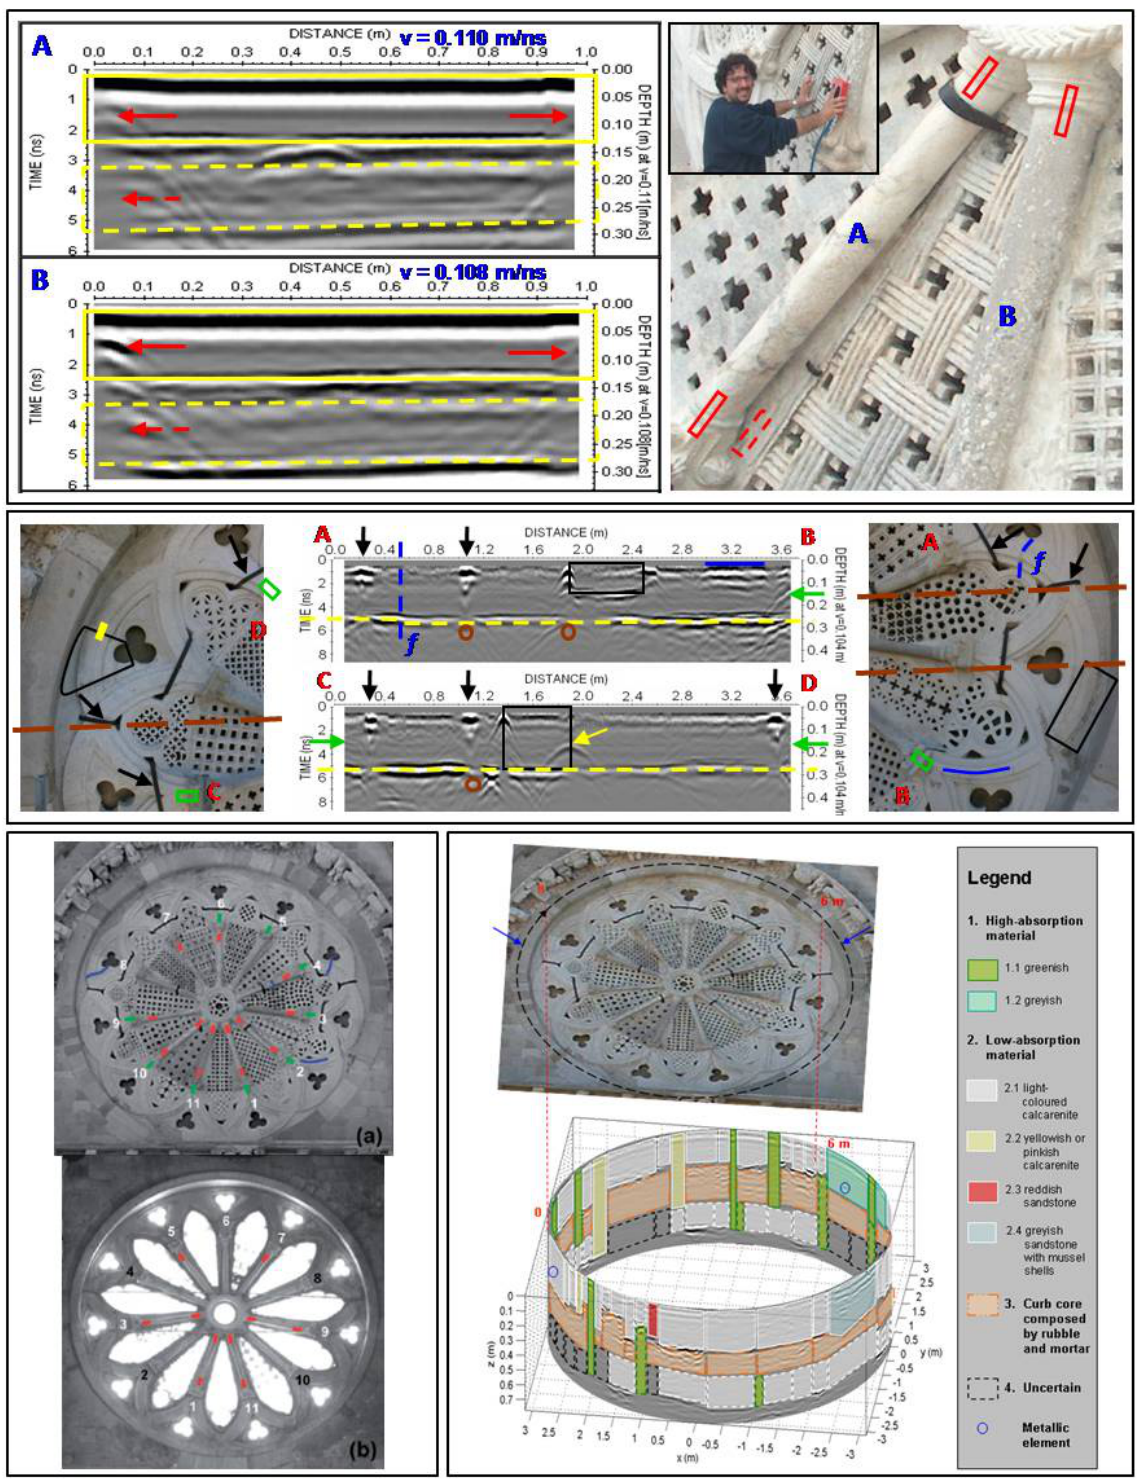
Fig. 3. Main results of the 1500MHzGPR survey on the columns (top), intersecting arched ribworks (middle) and ashlar curb (bottom-right) with an overview of the GPR findings (fractures and iron bolts) inside the architectural elements of the rose window from the (a) external and (b) internal side of the fac¸ade (bottom-left) (see text for